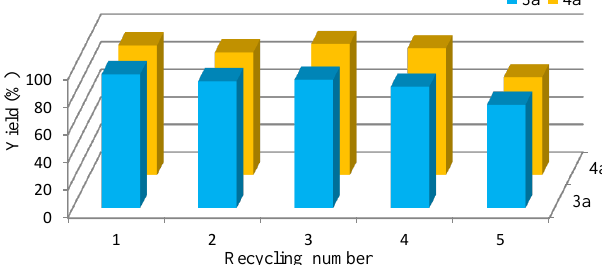
Figure. 1 Reusability of the [TBDH][TFE] system. Reaction conditions: 1a (302.4 mg, 2.0 mmol), 2a (168.2 mg, 2.0 mmol), [TBDH][TFE] (71.8 mg, 15 mol%), CO 2 (1 atm), 80 °C, 12 h.